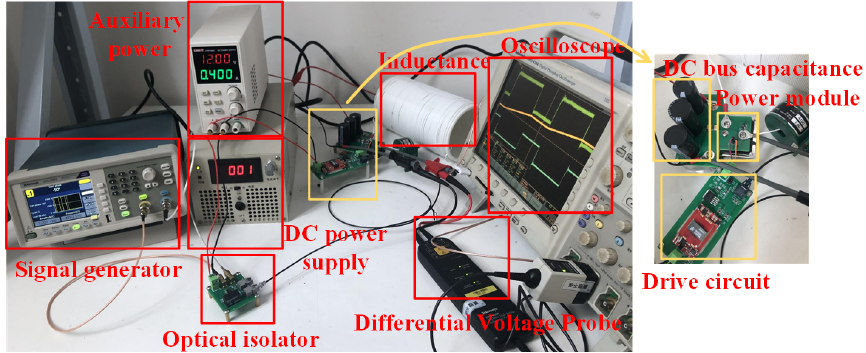
Figure 13. Double pulse test bench.